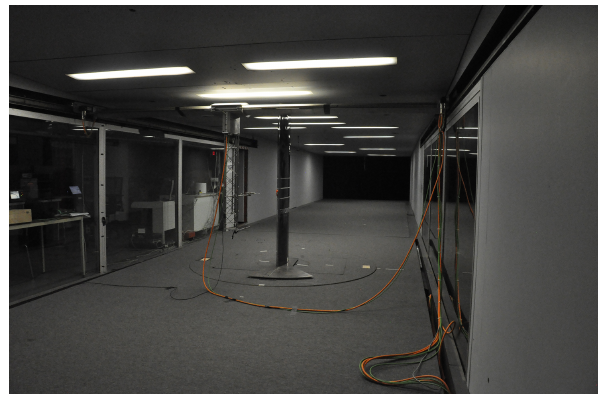
Figure 1. The NSA wind tunnel facility of CSTB with the 2D NACA 65 4 -421 blade section